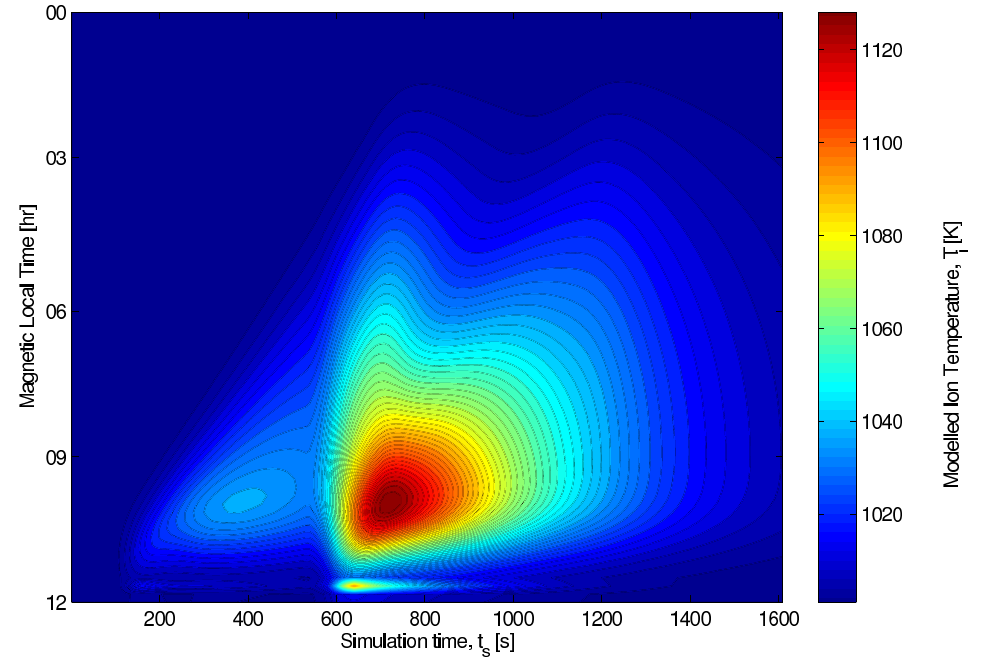
Fig. 5. A formedogram of the amplitude of the ion temperature response to the series of two reconnection pulses. The plot colour-codes the ion temperature as a function of simulation time t s (horizontal axis) and magnetic local time (vertical axis: where 00 MLT corresponds to simulated station number 72 and 12:00 MLT corresponds to simulated station 0; all stations are at a latitude of 67 ◦ ). This plot is the same as Fig. 6 of Morley and Lockwood (2005), but with a second burst of reconnection, identical to the first, 8min after the commencement of the first. Note the change in the ion temperature scale compared with that used by Morley and Lockwood (2005), which is required because much higher temperatures are driven in response to the second